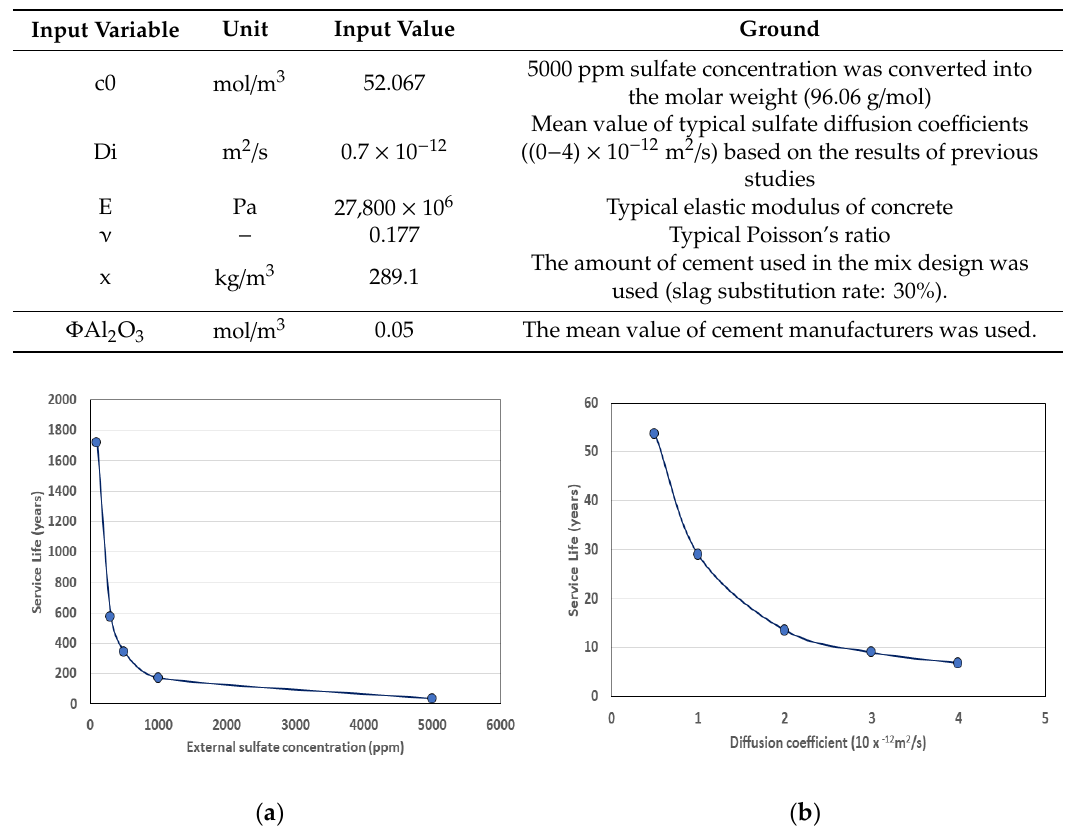
Table 4. Input constants for Atkinson model.